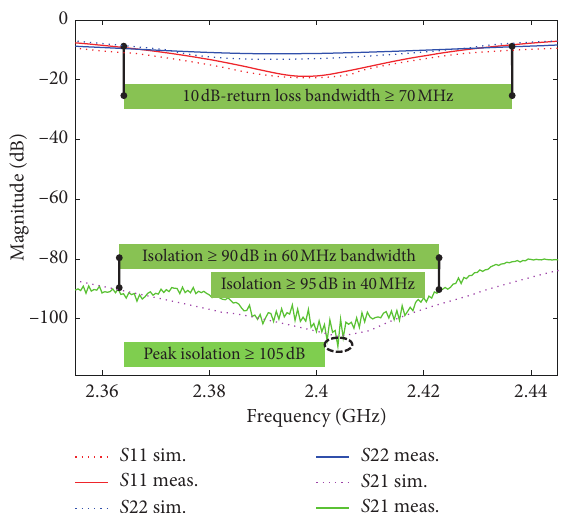
Figure 7: The simulated and experimentally recorded S antenna.